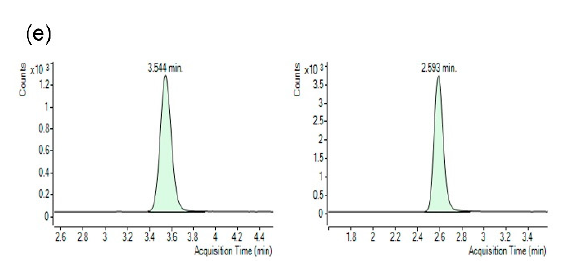
Figure 2. Multiple reaction monitoring LC–MS / MS chromatograms of KD025 (left) and IS (right) obtained by deproteinization of ( a ) blank rat plasma, ( b ) blank rat plasma spiked with 250 ng / mL of IS, ( c ) blank rat plasma spiked with 1 ng / mL of KD025 and 250 ng / mL of IS, ( d ) blank rat plasma spiked with 5 ng / mL of KD025 and 250 ng / mL of IS, and ( e ) rat plasma at 30 min after PO administration of KD025 at a dose of 5 mg / kg.